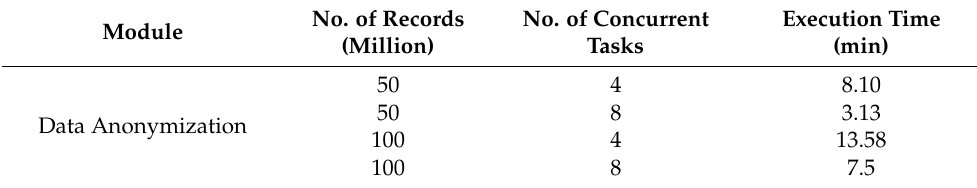
Table 6. Performance evaluation results for data